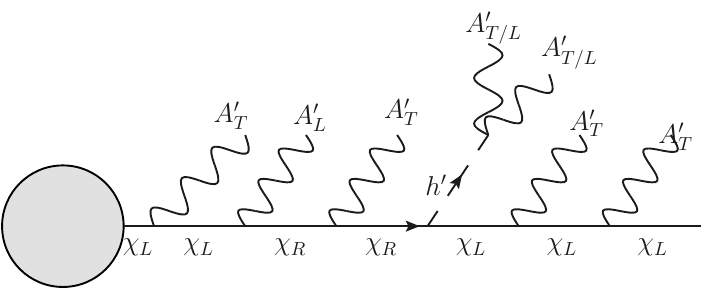
Figure 1 . Illustration of dark shower in the Chiral